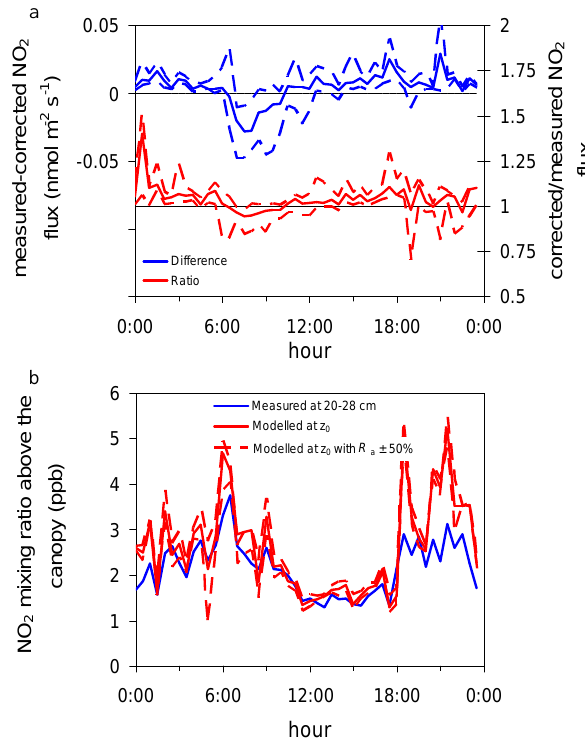
Fig. 7. (a) Half-hourly median (solid line) and interquartile range Figure 7: (a) Half hourly median (solid line) and interquartile range (dotted lines) of the 2 (dotted lines) of the difference (blue lines) and the ratio (red lines) difference (blue lines) and the ratio (red lines) between measured NO 2 fluxes at z = 2.0 m and 3 between measured NO 2 fluxes at z = 2 . 0m and NO 2 fluxes cor- rected for chemical reactions above the canopy from 29 August to NO 2 fluxes corrected for chemical reactions above the canopy from 29 August to 20 4 20 September 2005. (b) Comparison between measured (blue line) September 2005. (b) Comparison between measured (blue line) and modelled (red lines) NO 2 5 and modelled (red lines) NO 2 mixing ratio above the canopy. Dot- mixing ratio above the canopy Dotted lines are mixing ratios modelled with an uncertainty of 6 ted lines are mixing ratios modelled with an uncertainty of ± 50% for the aerodynamic resistance. For details see ± 50 % for the aerodynamic resistance. For details see text. 7